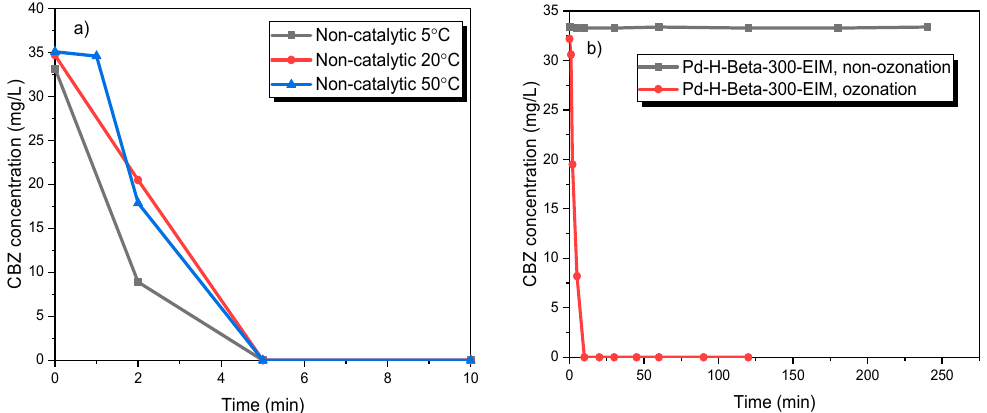
Figure 4. ( a ) CBZ degradation by ozonation at different temperatures (5 °C, 10 °C, 20 °C and 50 °C). ( b ) CBZ degradation by catalysis in the presence and absence of ozone at temperature 20 °C (stirring speed = 900 rpm, C O3,g = 21 mg/L, C CBZ = 35 mg/L, gas flow rate = 110 mL/min, C catalysts = 0.5 g/L).